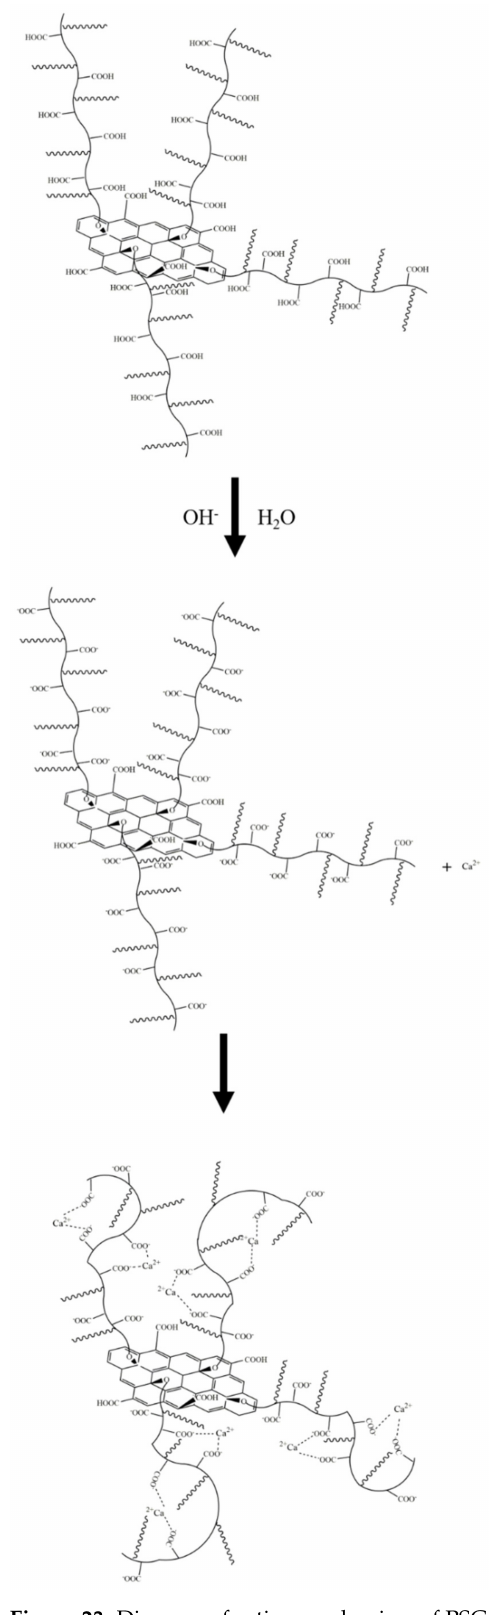
Figure 23. Diagram of action mechanism of PSG in Ca(OH) 2